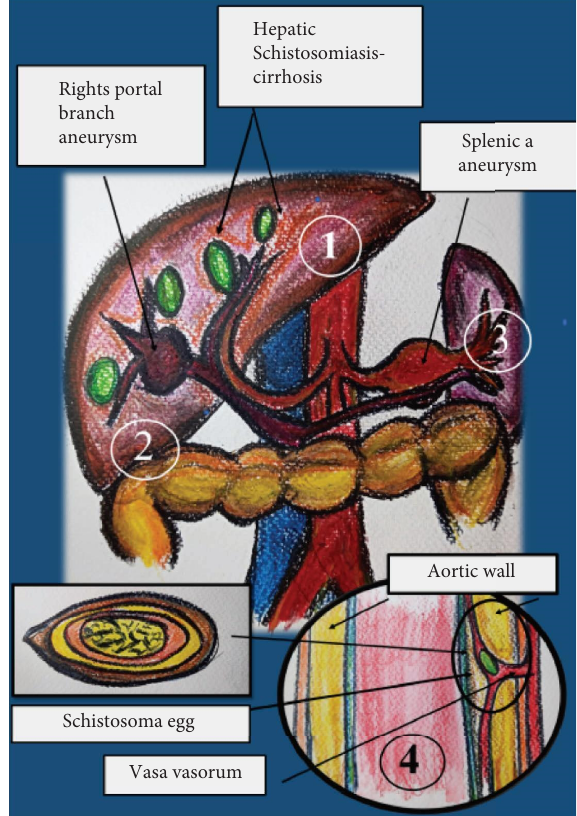
Figure 3: Aneurysms and schistosomiasis. Physiopathology behind portal branch aneurysm and splenic artery aneurysm formation. (1) Seeding of hepatic vessels by Schistosoma eggs may lead to in- fammatory reaction in hepatic parenchyma, fbrosis, and direct damage to vessels. (2) Infammatory reaction and portal fbrosis due to Schistosoma oviposition in hepatic vessels may lead to portal hypertension, which may induce aneurysms by hemodynamic mechanisms in visceral vessels. (3) Splenic artery aneurysm may be secondary to portal hypertension. (4) Schistosoma eggs may seed arterial wall through vasa vasorum, inducing direct damage and predisposing to aneurysm formation. Splenic a. � splenic